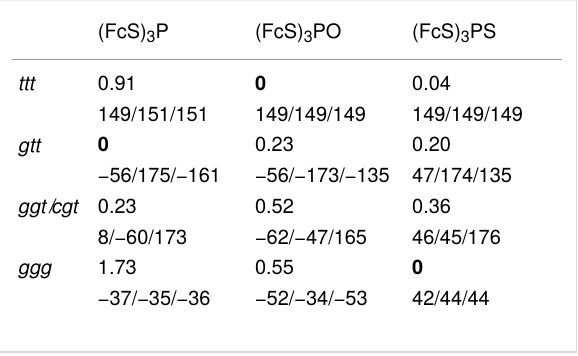
unsymmetrical structure with three ferrocenylthio groups exhib- iting different orientations towards the phosphorus lone elec- tron pair (Figure 1).